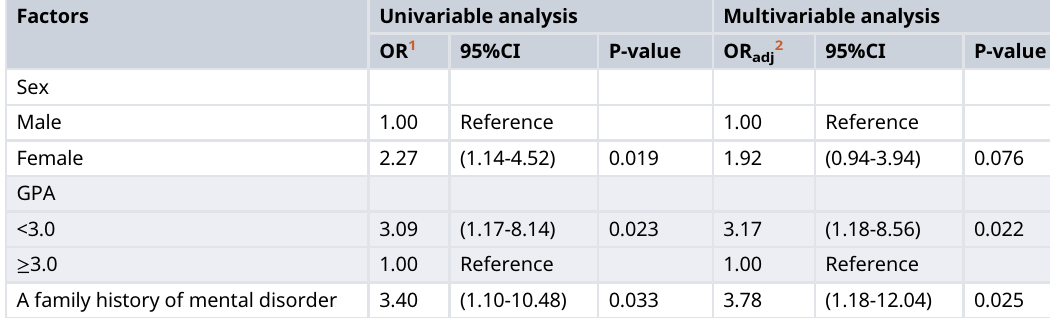
Table 5. Factors associated with mental health problems (CGI) analysed by univariable and multivariable regression analysis (n=154).